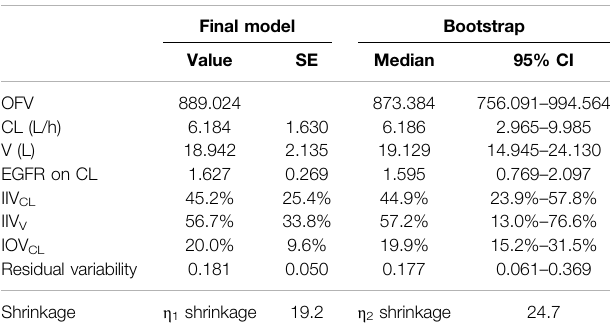
TABLE 2 | Parameter values of the fi nal model and bootstrap results obtained in 1,000 resampled